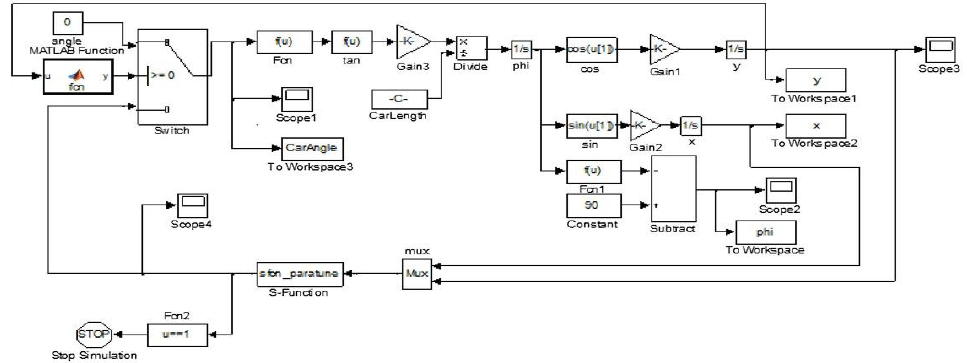
Figure 9. Simulation model of the automatic parking system in Simulink.